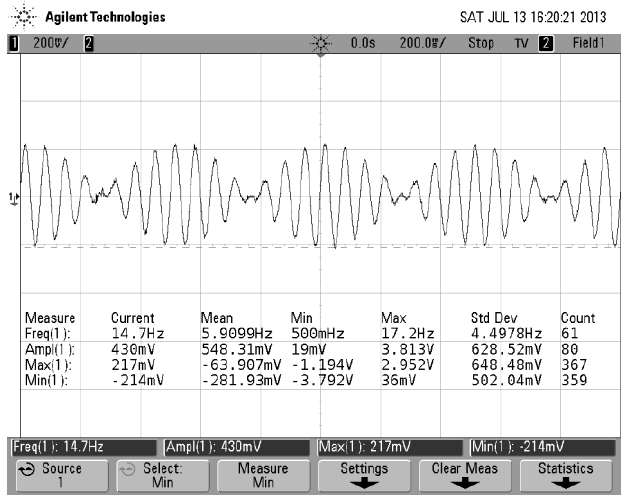
Figure 8. AM waveform.